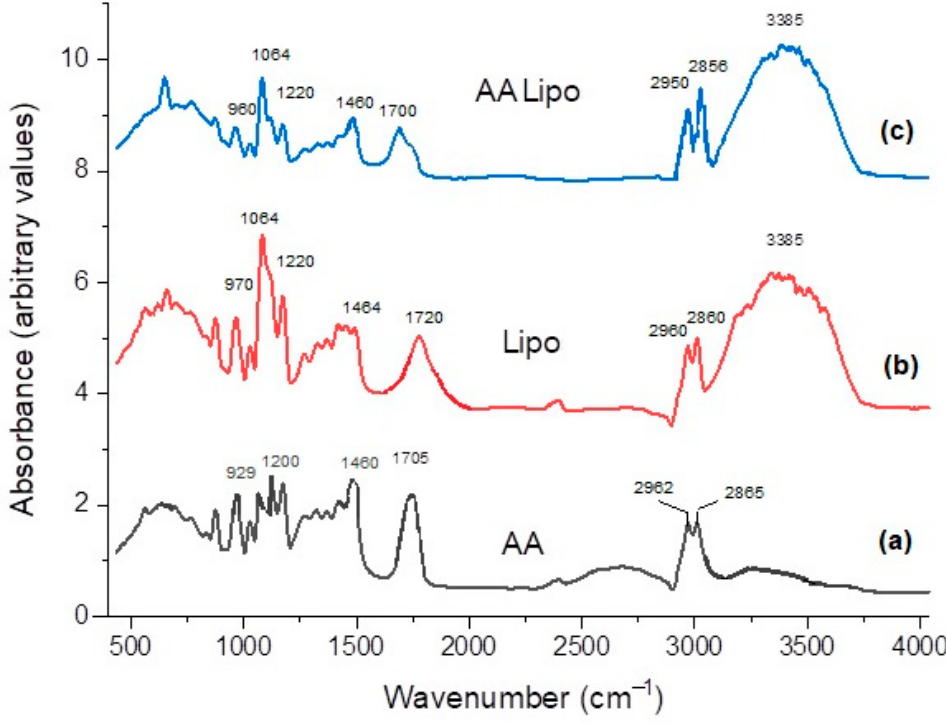
Figure 2. FTIR spectra of powder azelaic acid ( a ), blank liposomes ( b ), and azelaic-acid-loaded liposomes ( c ).